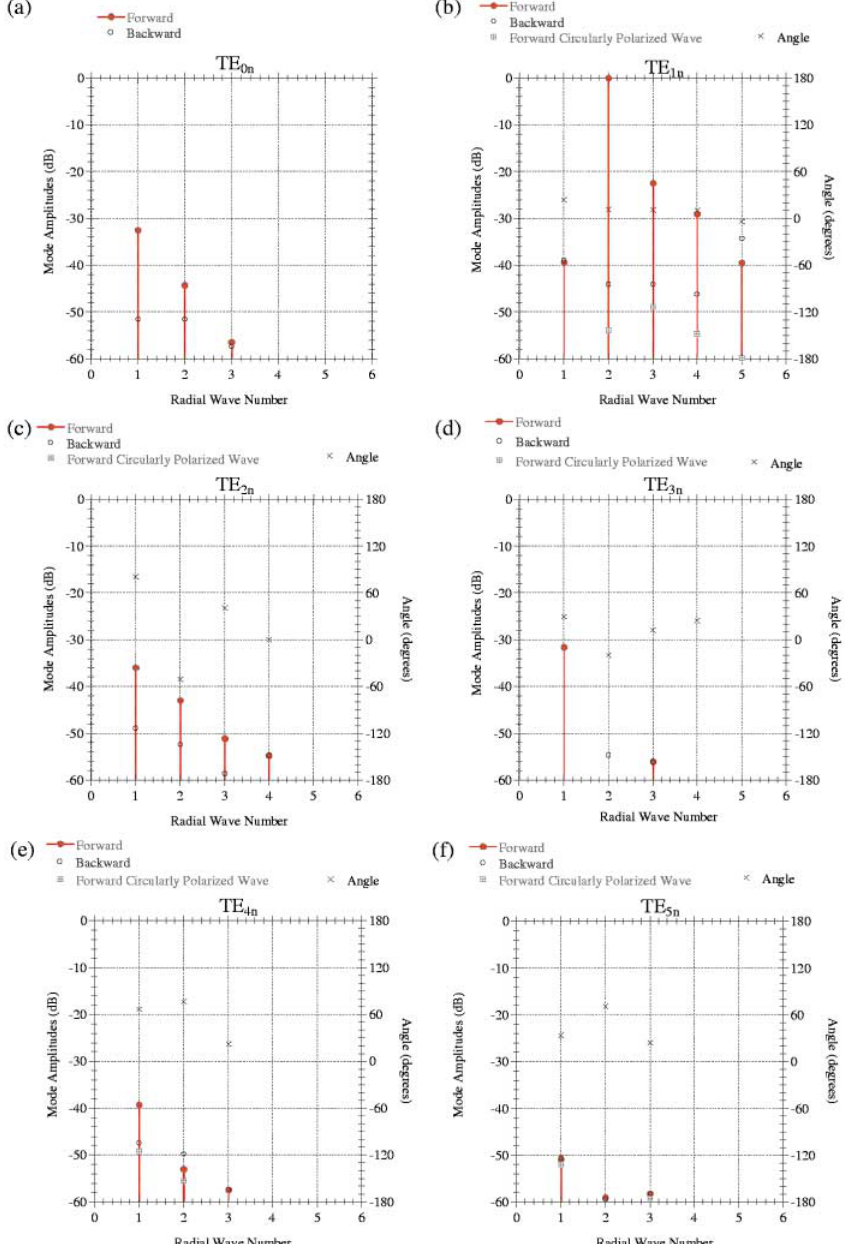
FIG. 11. (Color) Measured mode spectrum of the TE 12 mode transducer. The decomposition is done in terms of a linearly polarized component and a circularly polarized one. The angles in these graphs are the inclination angle of the linearly polarized field component with respect to the vertical